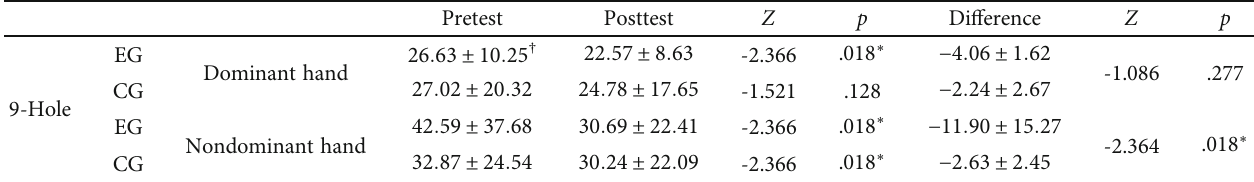
Table 4: Changes of Nine-Hole Pegboard Test before and after intervention ( N = 14 ).